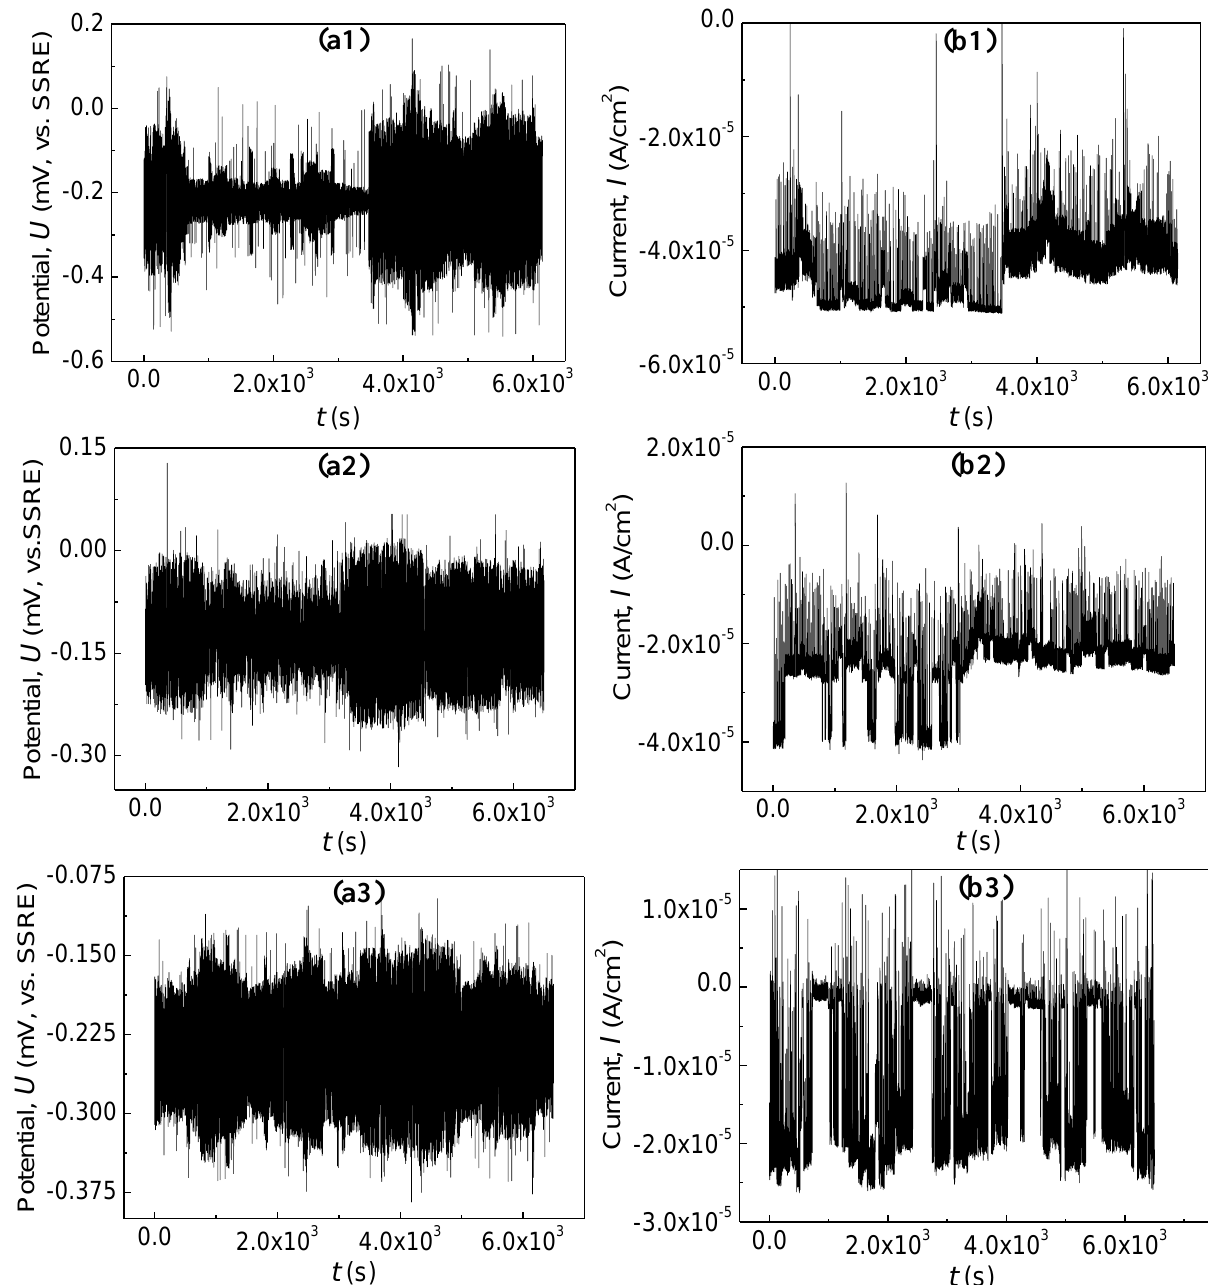
Figure 7. The electrochemical emission data of the active state RC panel. ( a1 ), ( a2 ), ( a3 ) and ( b1 ), ( b2 ), ( b3 ) are the electrochemical potential emission and electrochemical current emission of the wireless motes SN1, SN2 and SN3 located along the diagonal line of the RC panel in Figure 6,